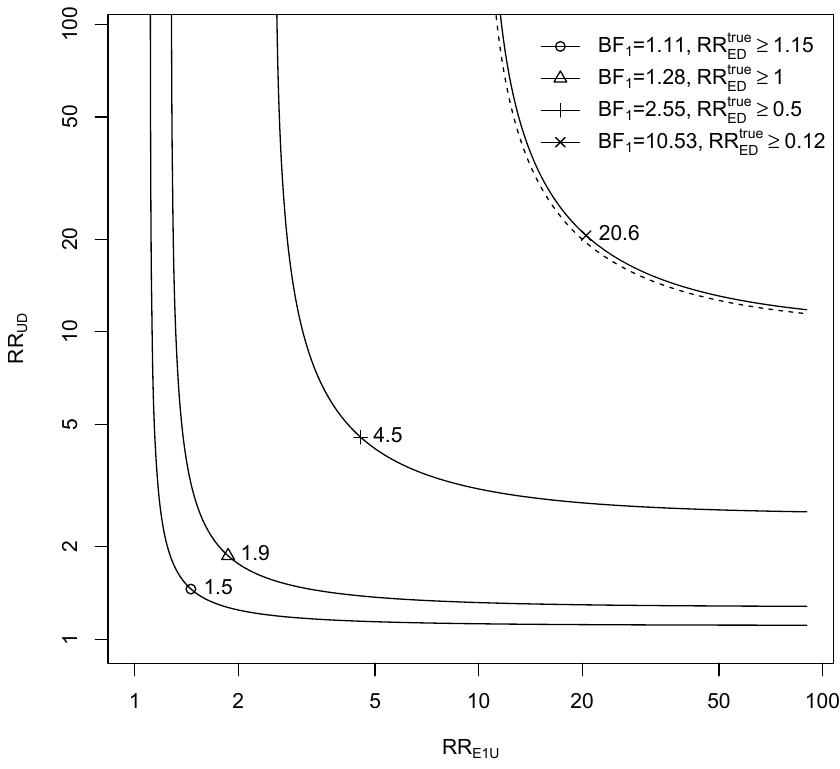
Figure 2: Contour plot for BF 1 and DV’s lower bound for RR true